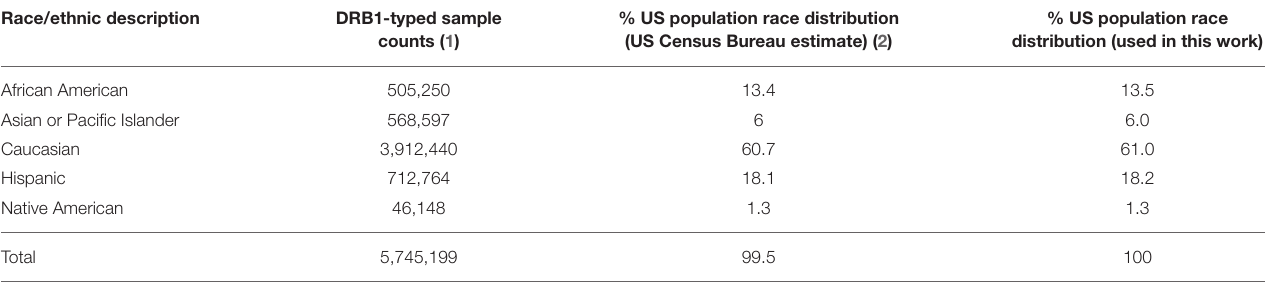
TABLE 1 | The samples used for the creation of the background distribution of HLA-DRB1 alleles for the US population. Race/ethnic